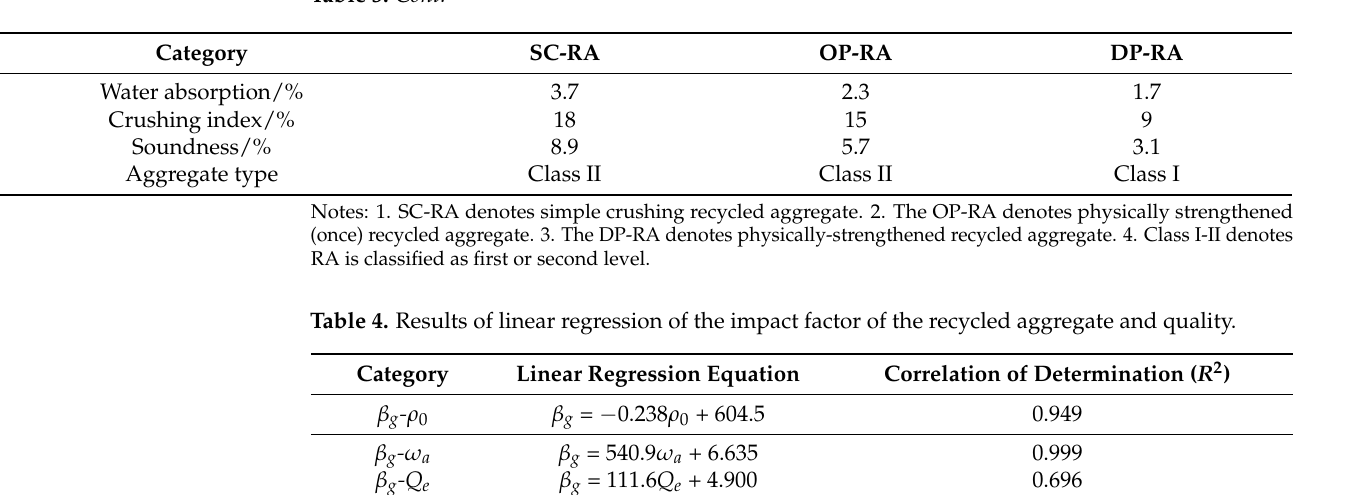
Table 3. Basic performance indices of recycled coarse aggregate. Table 3. Cont.